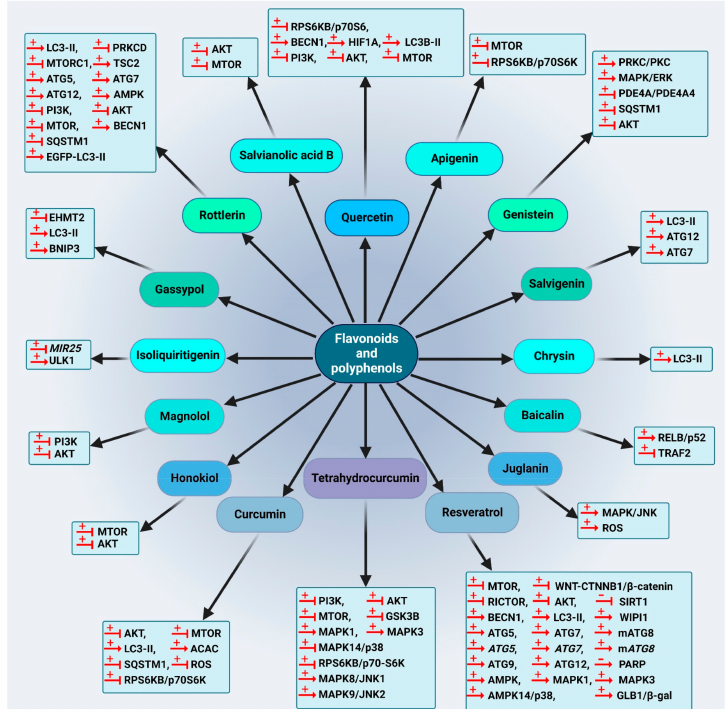
Figure 7. The schematic role of alkaloids on different proteins involved in the autophagy pathway. Alkaloids regulate autophagy in different ways. Vincristine and carbazoles have been demonstrated to inhibit autophagy by suppression of CD24, suppression of the PTEN-AKT-MTOR pathway and enhancement of SSQTM1/p62. Other alkaloids induce autophagy via activation of AMPK, TSC2, MAPK/JNK-AP-1 and BECN1, and enhance MYC/c-Myc, LC3-II and ATG7 expression. Moreover, inhibiting the AKT-MTOR pathway has a key function in induced autophagy by alkaloids. Moreo- ver, another alkaloid named tetrandrine induces autophagy by suppressing the WNT- CTNNB1/β - catenin pathway and decreasing MTA1 expression. → : Indicates activation or an increase in the mentioned protein expression. Figure 12. The schematic role of flavonoids and phenolic compounds on the proteins involved in the autophagy pathway. mATG8, mammalian Atg8-family proteins. → : Indicates activation or an increase in the mentioned protein expression. : Indicates deactivation or a decrease in the mentioned protein expression. − and +: Indicate the effect of the proteins on different pathways ( − means negative effect and + means positive effect). The figure was created with BioRender.com. Licensing Right OG24OB731X, 21 November 2022.